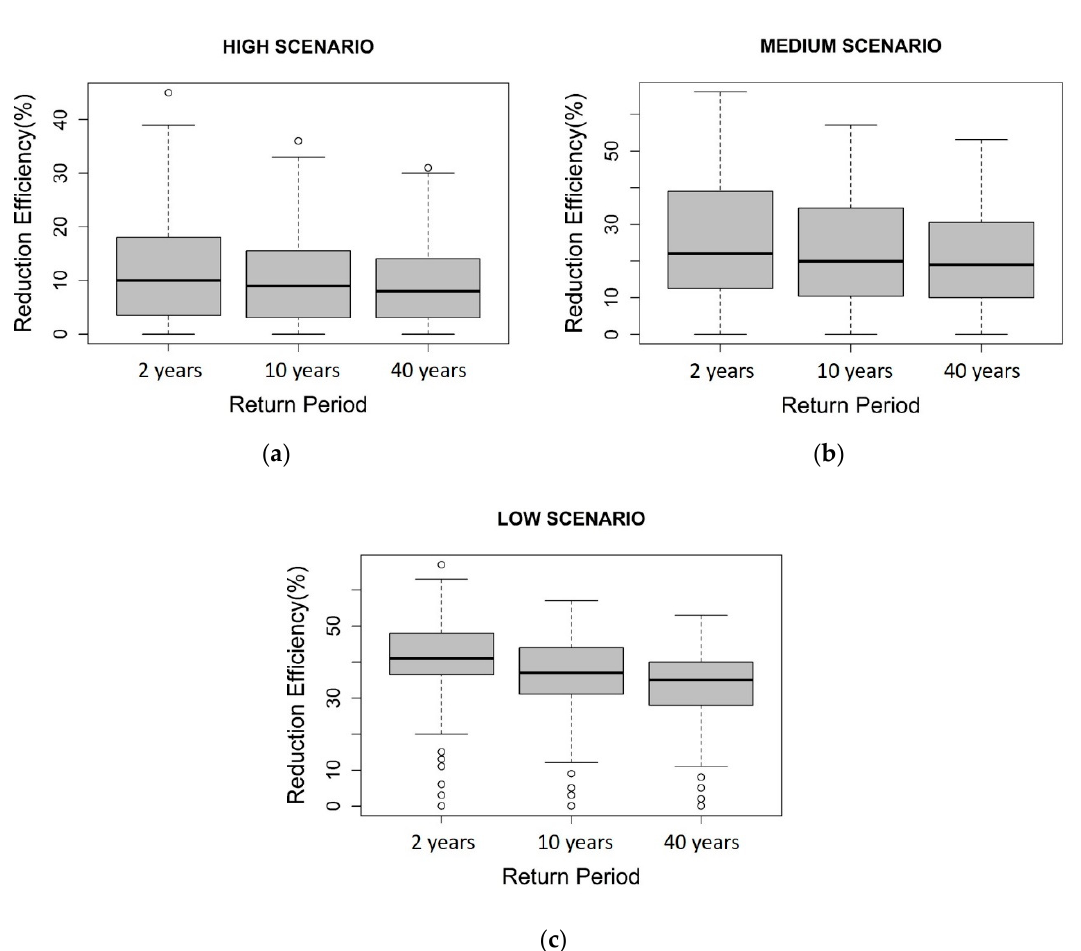
Figure 7. Variation in TSS reduction efficiency of sub-catchments with various design storms: ( a ) high scenario means 10% TSS removal efficiency at the outfall; ( b ) medium scenario means 20% TSS removal efficiency; ( c ) low scenario means 30% TSS removal efficiency.